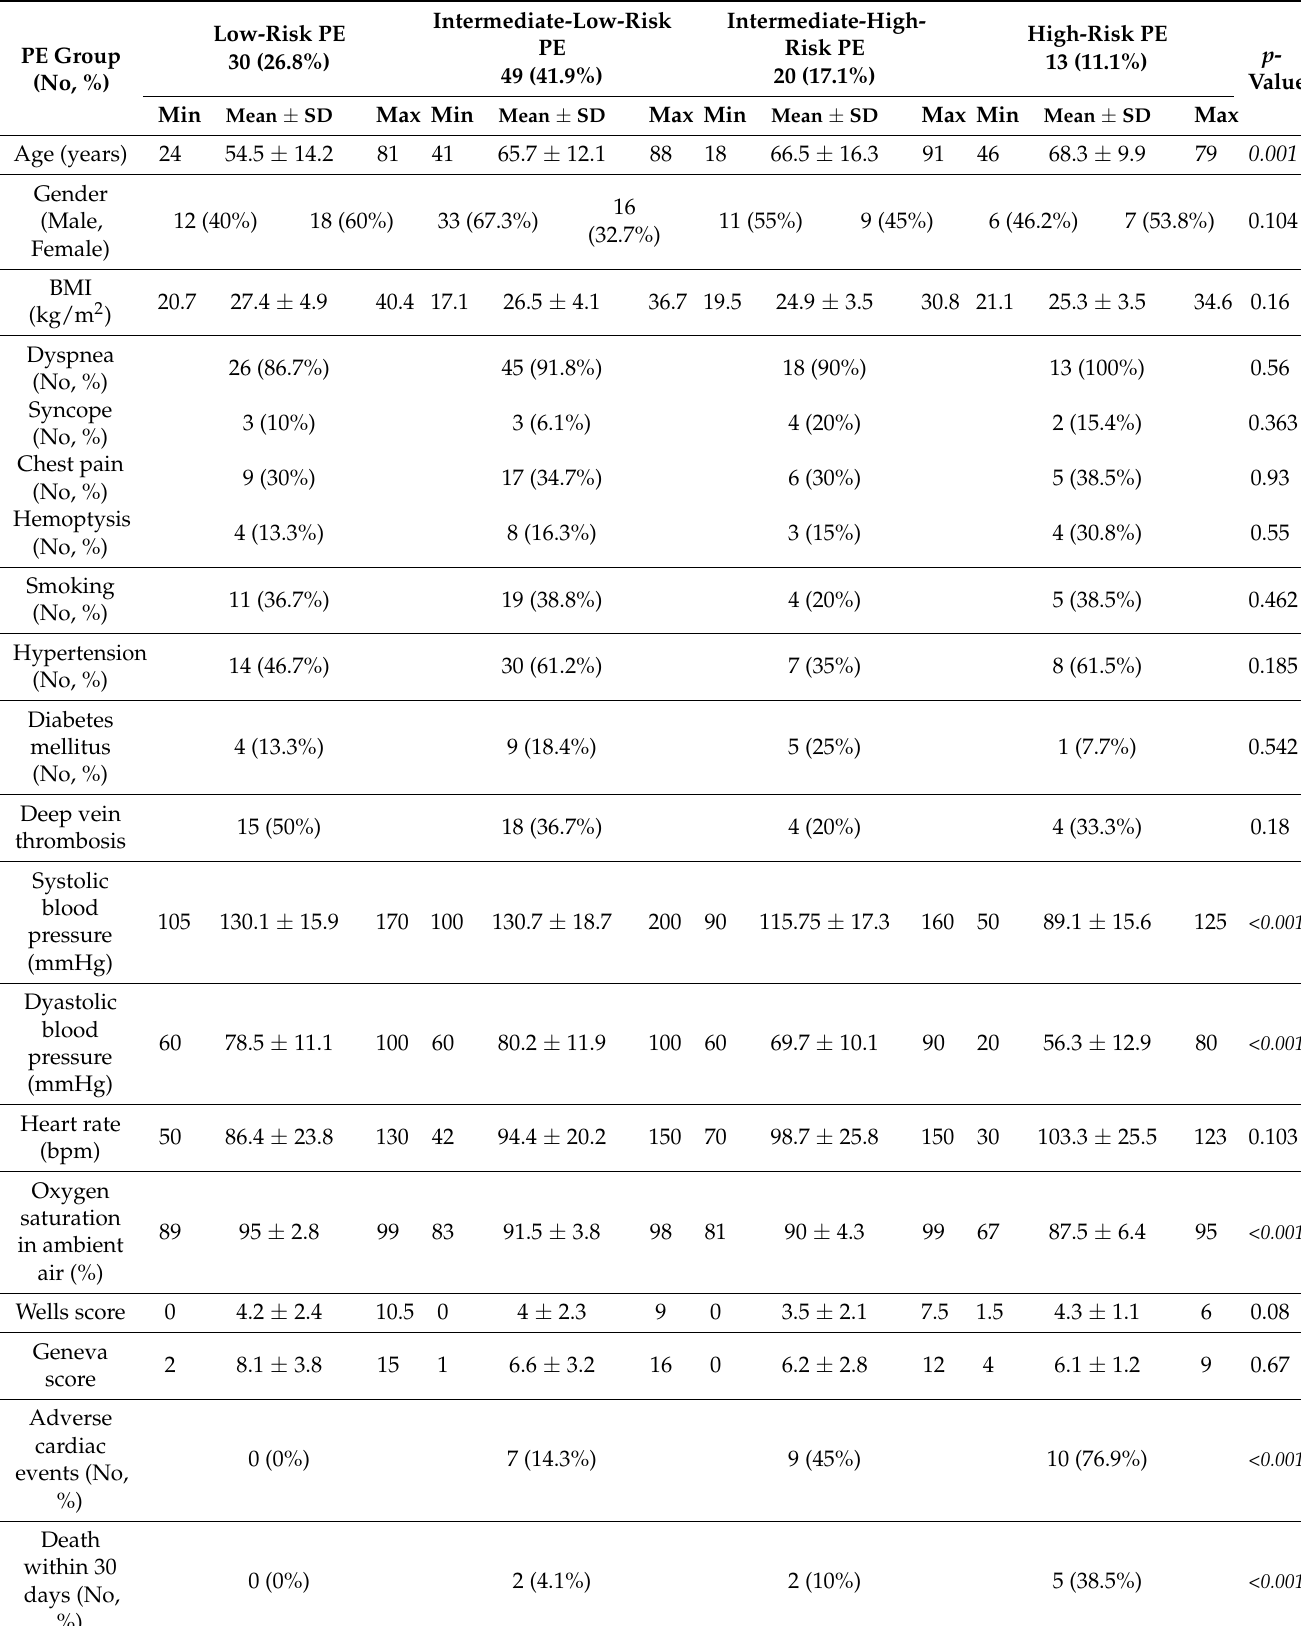
Table 2. Demographic and general characteristics according to risk